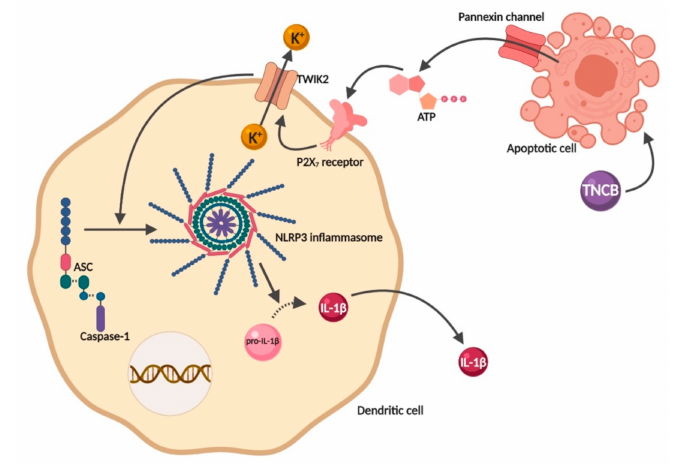
Figure 4. Trinitro-chlorobenzene (TNCB)-induced NLRP3 inflammasome activation via K + channel after ATP release. Upon contact with the skin sensitizer TNCB, keratinocytes release ATP through the pannexin channel, which then binds to the P2X7 receptor in the cell surface. Once activated, the P2X7 receptor induces K + e ffl ux through TWIK2, leading to a reduction in intracellular K + levels which activates the NLRP3 inflammasome. Once activated, inflammasome induces the maturation and secretion of IL-1 β . Created with